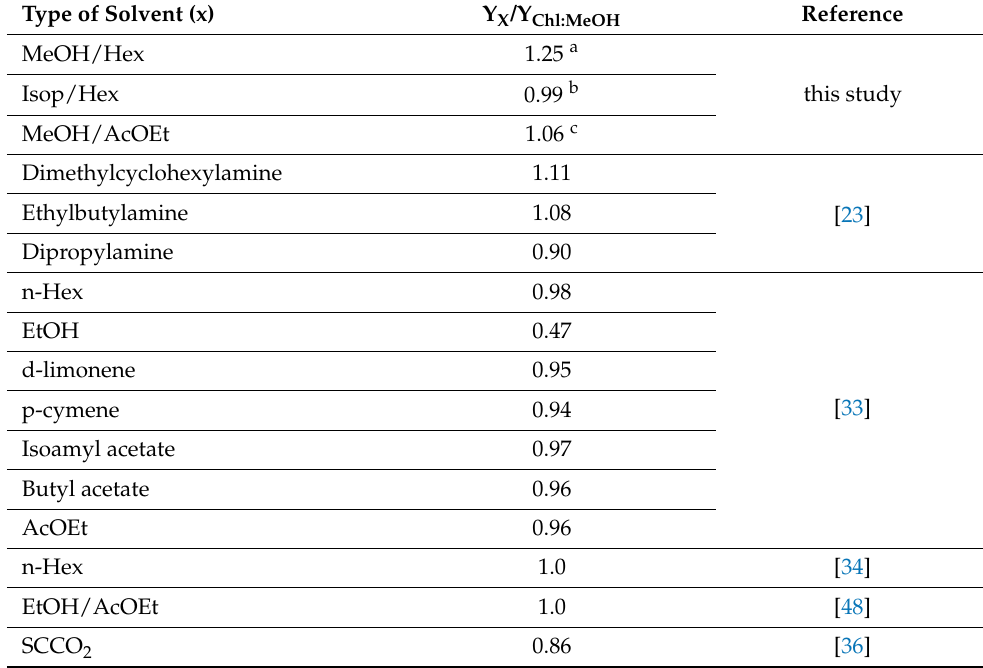
Table 5. Ratios of the reported maximum lipid yield values of solvent(s) X to the lipid yield values employing the conventional Chl:MeOH solvent